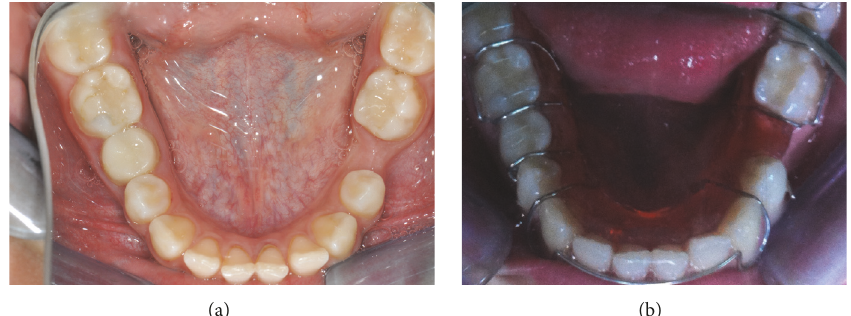
Figure 3: Intraoral view of left primary second molar extraction space (a). Removable space maintainer for space maintenance